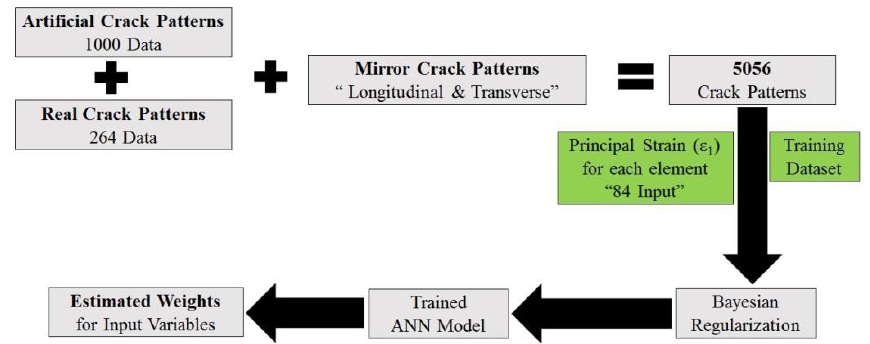
Figure 17. Strategy for achieving hazard map for the locations of higher risk cracking.